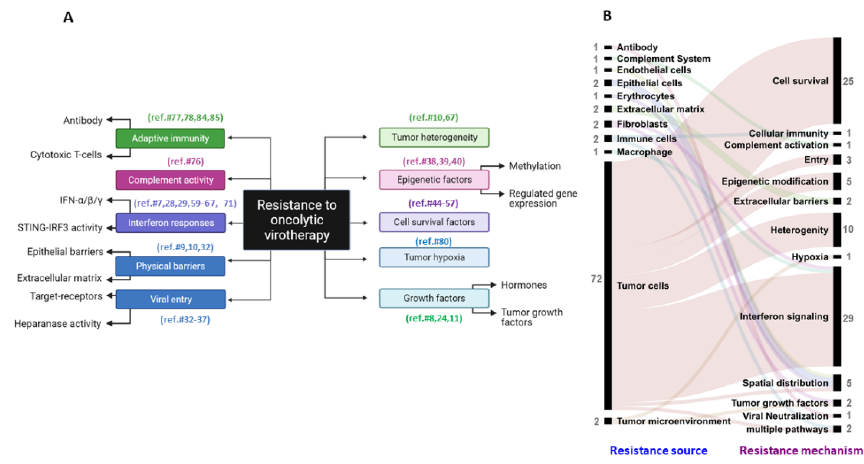
Figure 3. Resistance mechanisms undermining the efficacy of oncolytic viruses. ( A ) Types of resistance mechanisms and responsible molecular factors studied in reference to oncolytic viruses. The reference number of articles corresponding to the respective resistance mechanisms is provided in brackets. ( B ) Frequency of studies focusing on a particular resistance source and corresponding mechanism. Each link indicates an article. The number of articles studying a particular resistance source and resistance mechanism is indicated next to the label in grey.